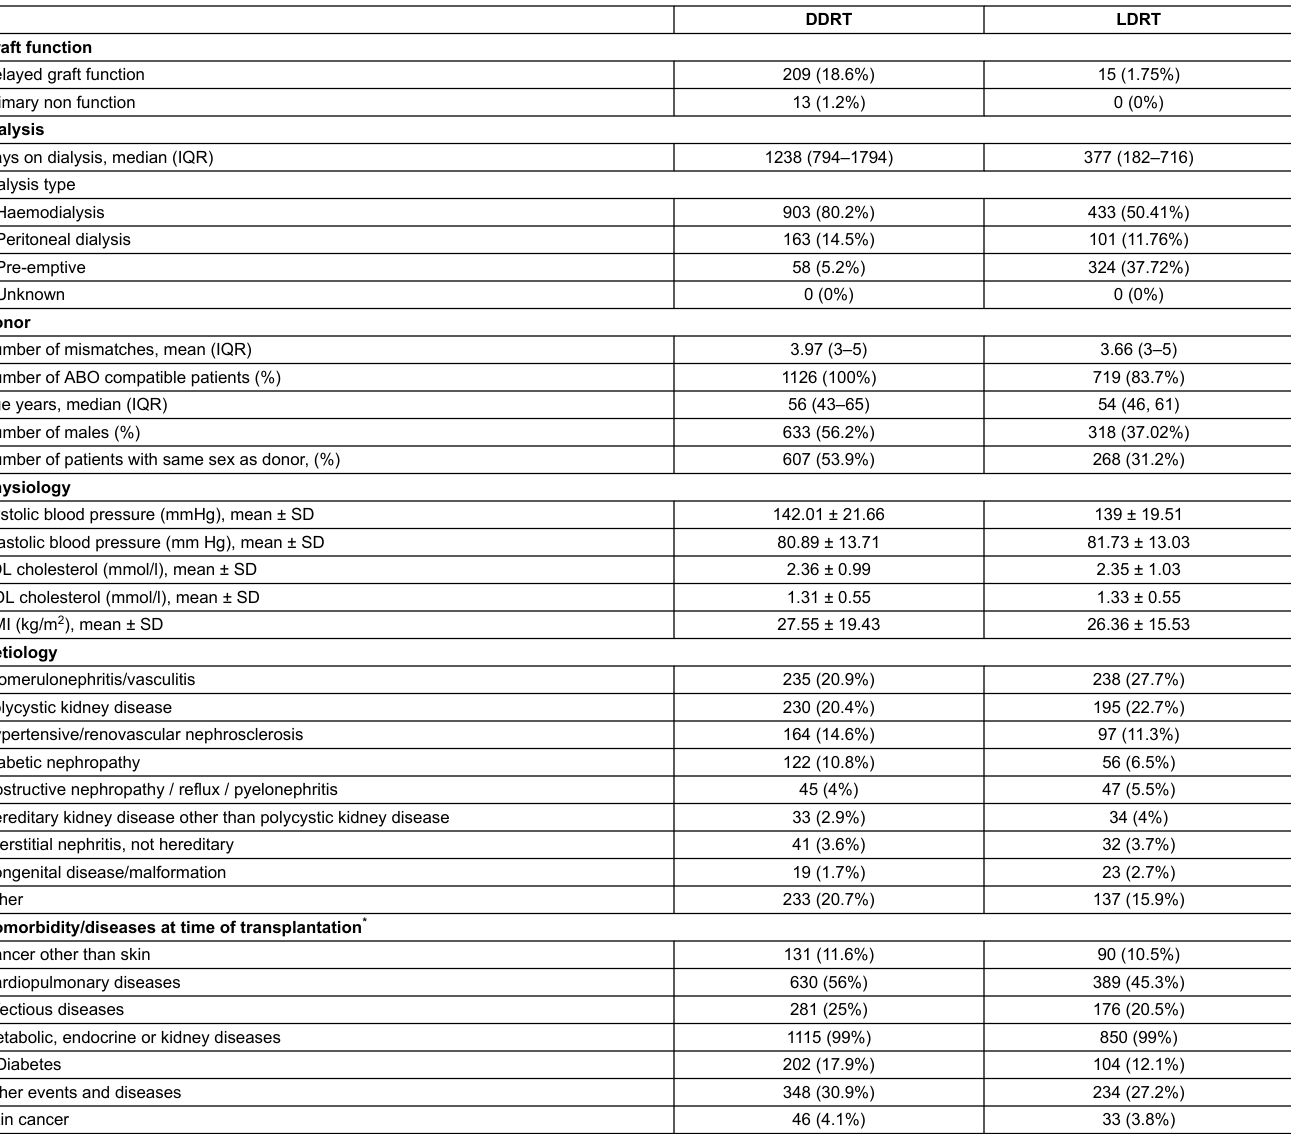
Table 3: Characteristics related to the transplant event of recipients by deceased (DDRT) and living (LDRT)